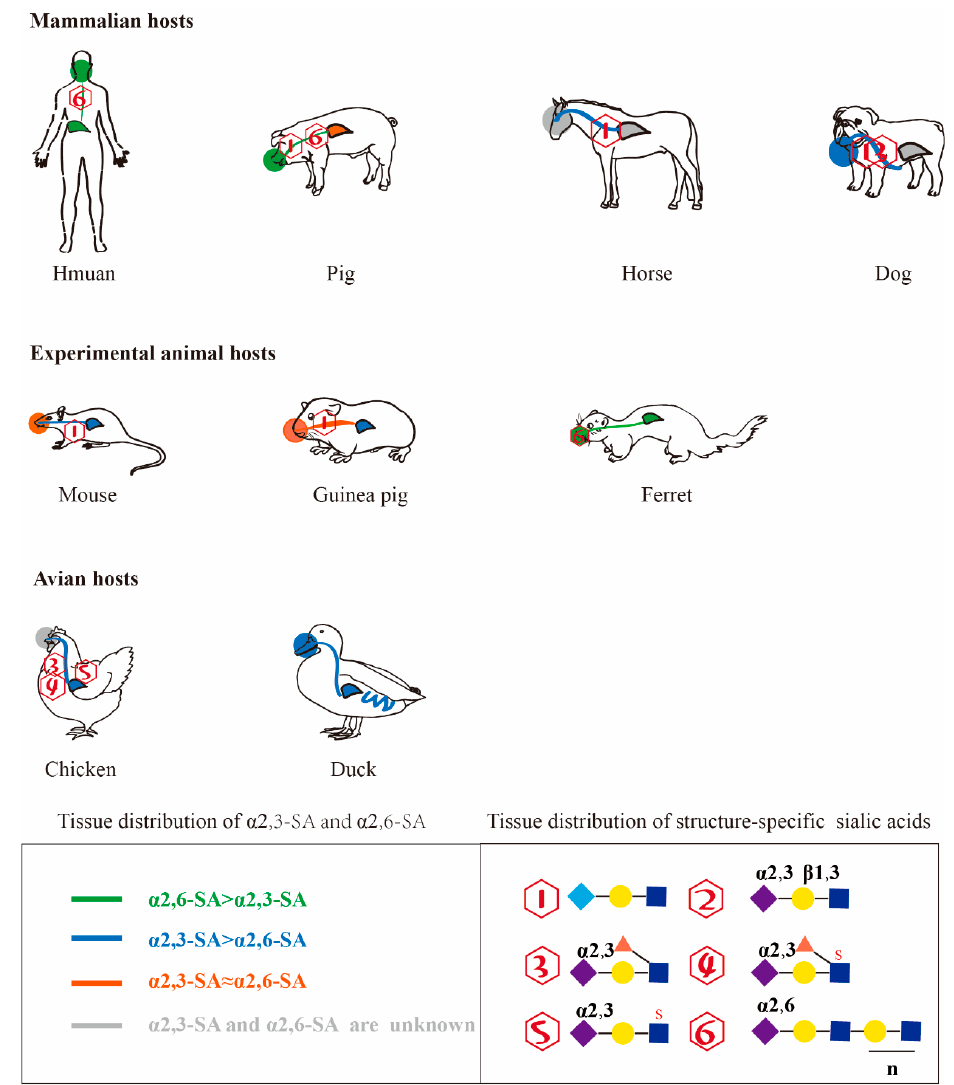
Figure 3. Characteristics of the distribution of sialylated glycan molecules in respiratory tract tissues of mammalian, experimental animal, and avian hosts.